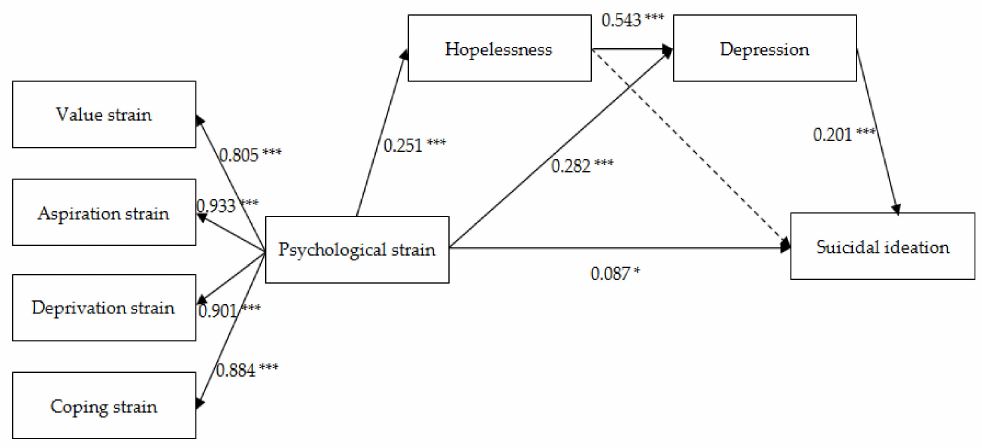
Figure 1. Serial mediating e ff ect of hopelessness and depression between psychological strain and suicidal ideation; * p < 0.05; *** p <